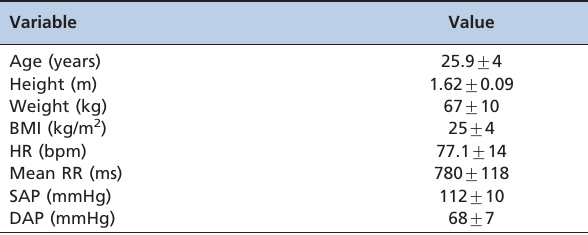
Table 1 - Baseline diastolic (DAP) and systolic arterial pressure (SAP), heart rate (HR), mean RR interval, weight, height and body mass index (BMI) of the volunteers.